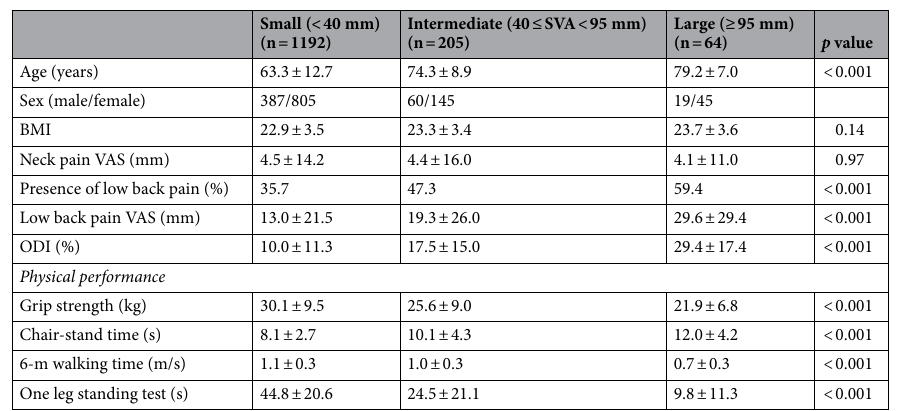
Table 3. Association between sagittal spinal alignment and pain/physical performance on radiographs. The data are shown as the mean ± standard deviation. One-way analysis of variance was used to assess differences among different distances of the C7 SVA. BMI, body mass index; ODI, Oswestry Disability Index; VAS, visual analog scale.